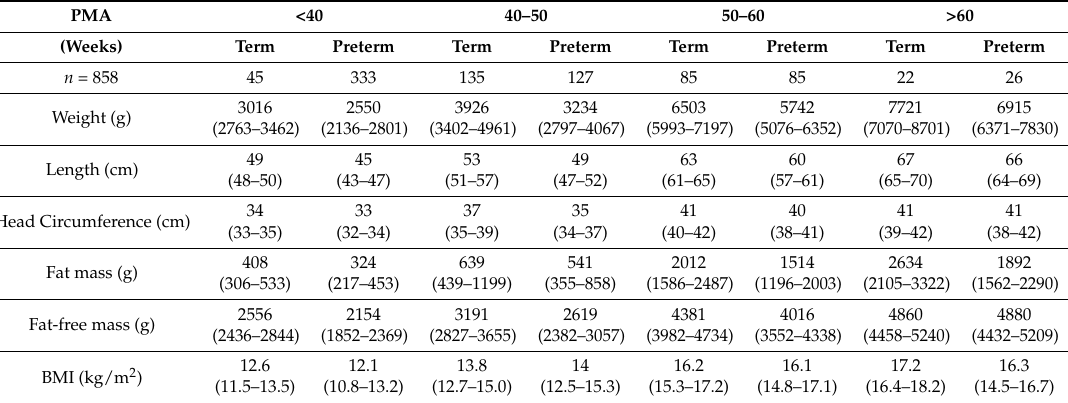
Table 2. Longitudinal change in anthropometric